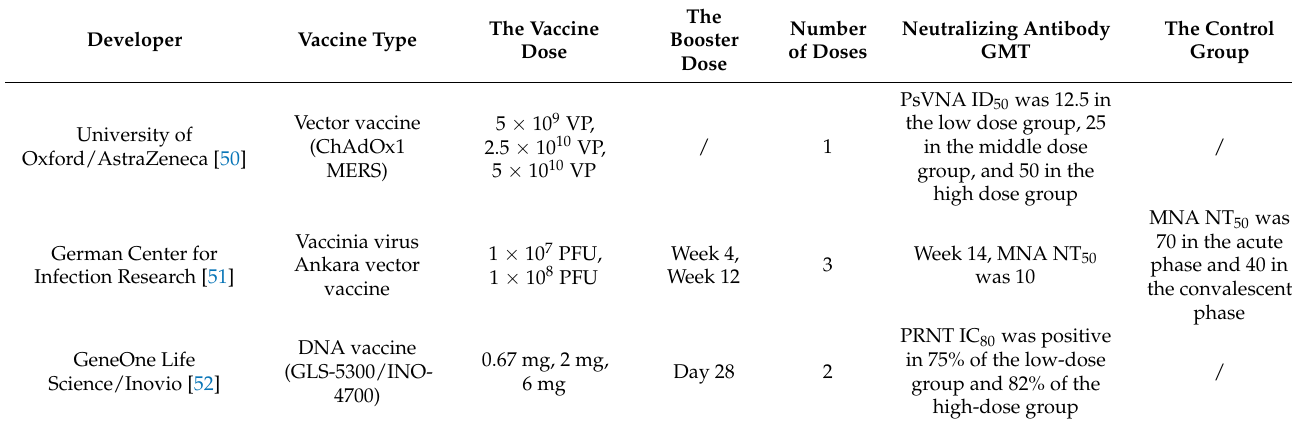
Table 2. Clinical trial results of MERS-CoV candidate